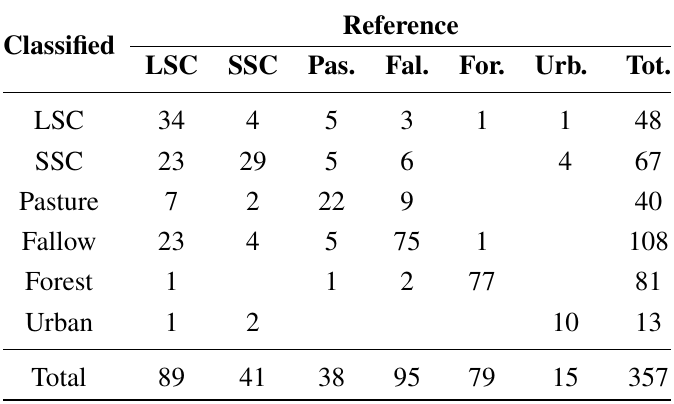
Table 3. Confusion matrix for the pixel-based classification of